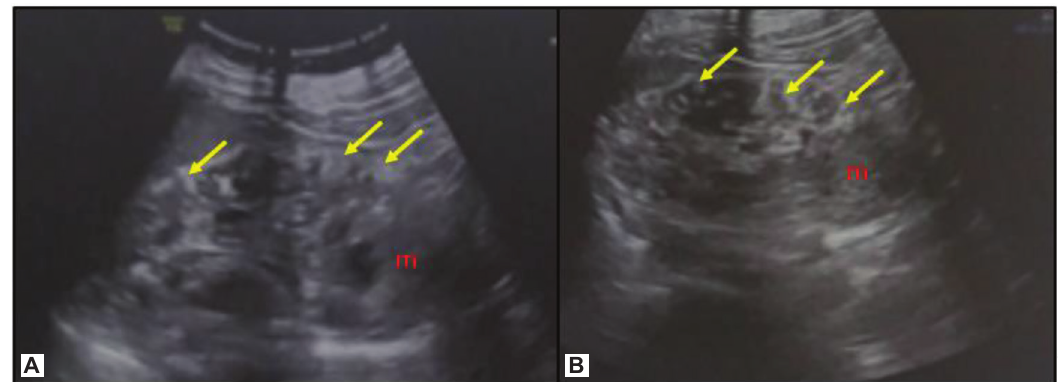
Figure 2: (A, B) Ultrasound images of the left kidney reveal multiple elongated echogenic focal lesions close to the cortex, sug- gesting angiomyolipomas. Note the mass from the lower pole